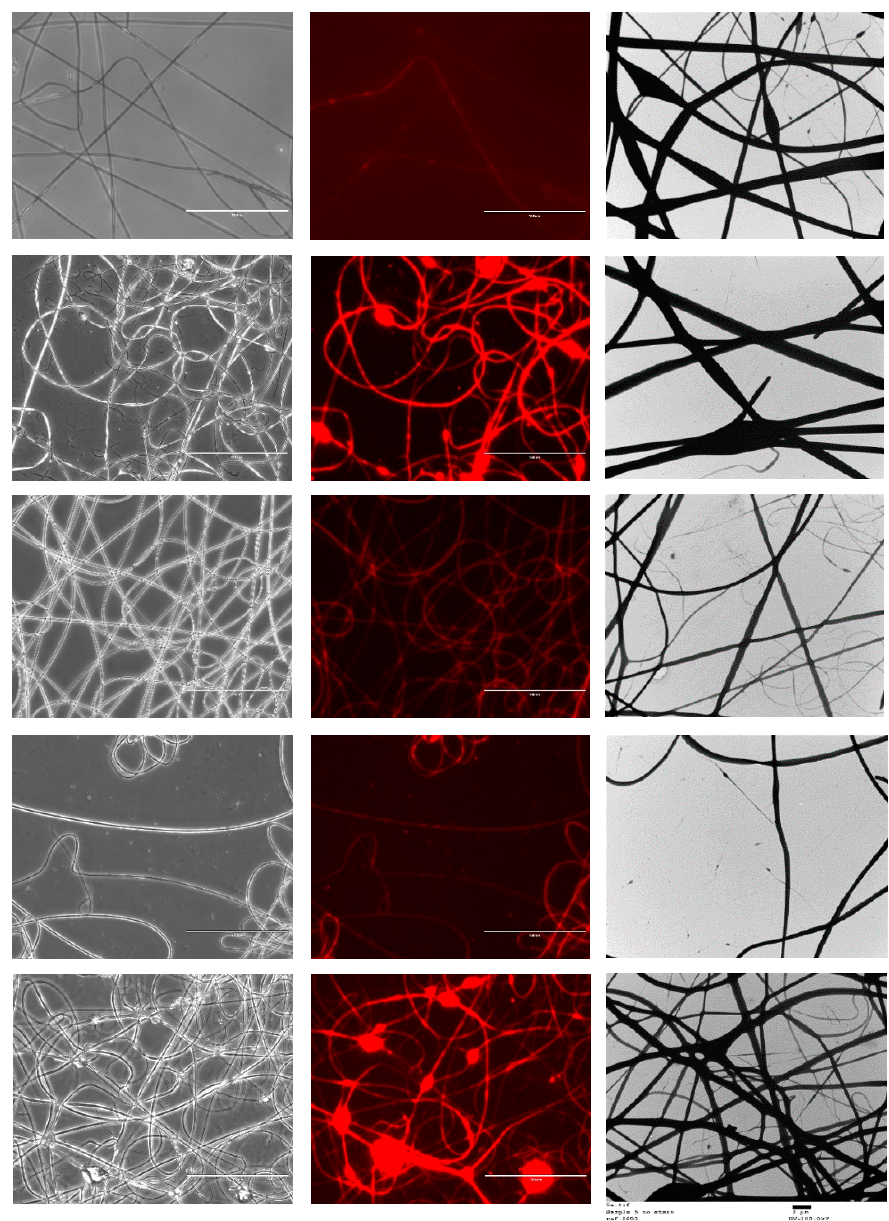
Figure 5. FL microscopy images of the five co-axial formulations. Scalebar represents 100 μ m. The images from top to bottom represent samples 1 to 5. TEM images are also represented; scalebar for the TEM images represents 2 μ m. Sample 1 is a placebo formulation whilst samples 2 to 5 contained CPM in the core.